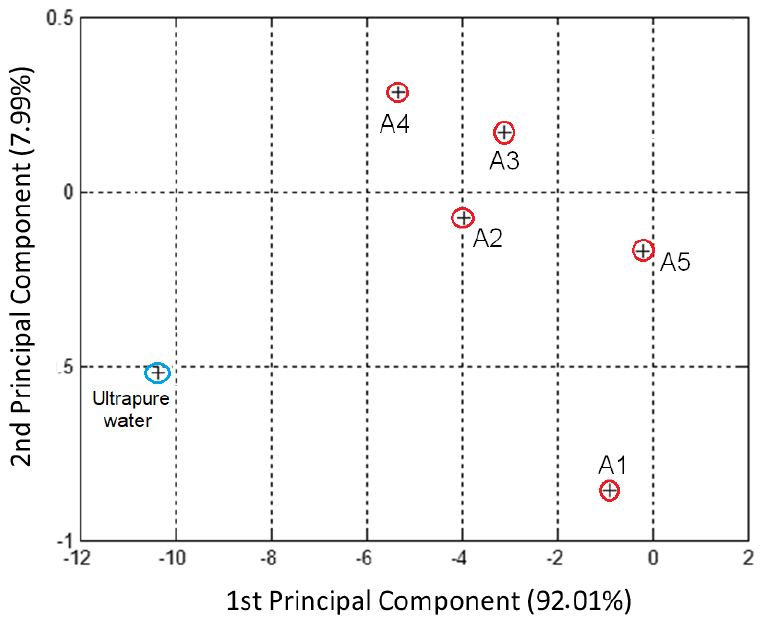
Fig. 11. Analysis of the Main Component (PCA) for effluent samples from a biodigestor septic tank, tap water, artesian well and ultrapure water included in the